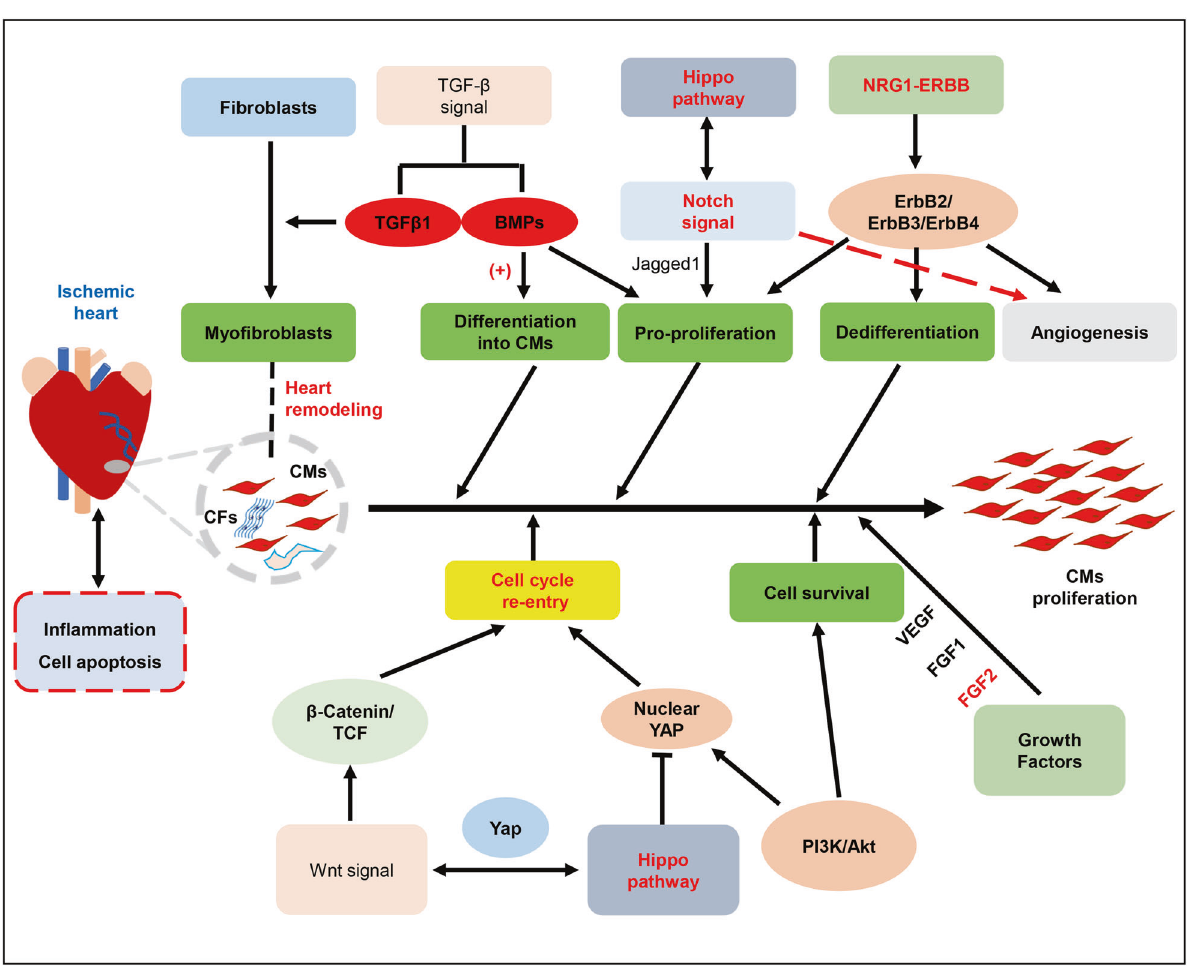
for Notch receptor. Wnt and TGF- β pathways are indirectly involved in critical regulation of cardiomyocytes proliferation and damaged heart repair and remodeling. CMs cardiomyocytes, CFs cardiac fi broblasts, TGF- β transforming growth factor β . ( + ):